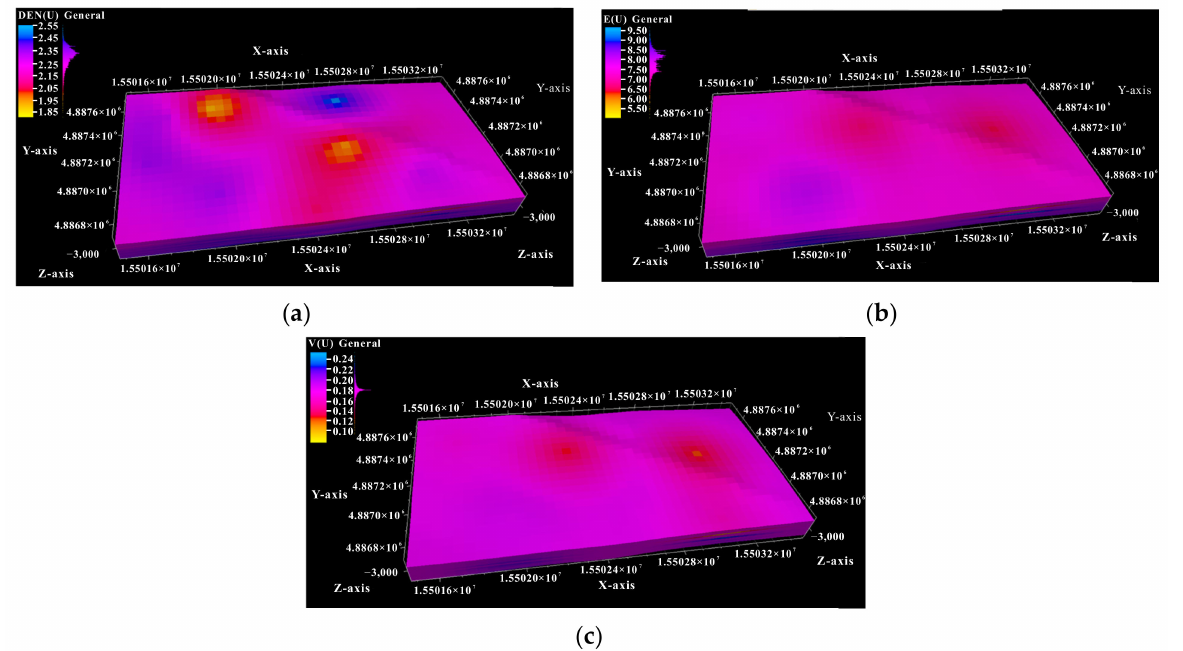
Figure 4. Mapped rock properties based on the FEM model of the target reservoir. ( a ) Density (unit: g/cm 3 ) distribution of the target formation. ( b ) Young’s Modulus (unit: GPa) distribution of the target formation. ( c ) Poisson’s Ratio distribution of the target